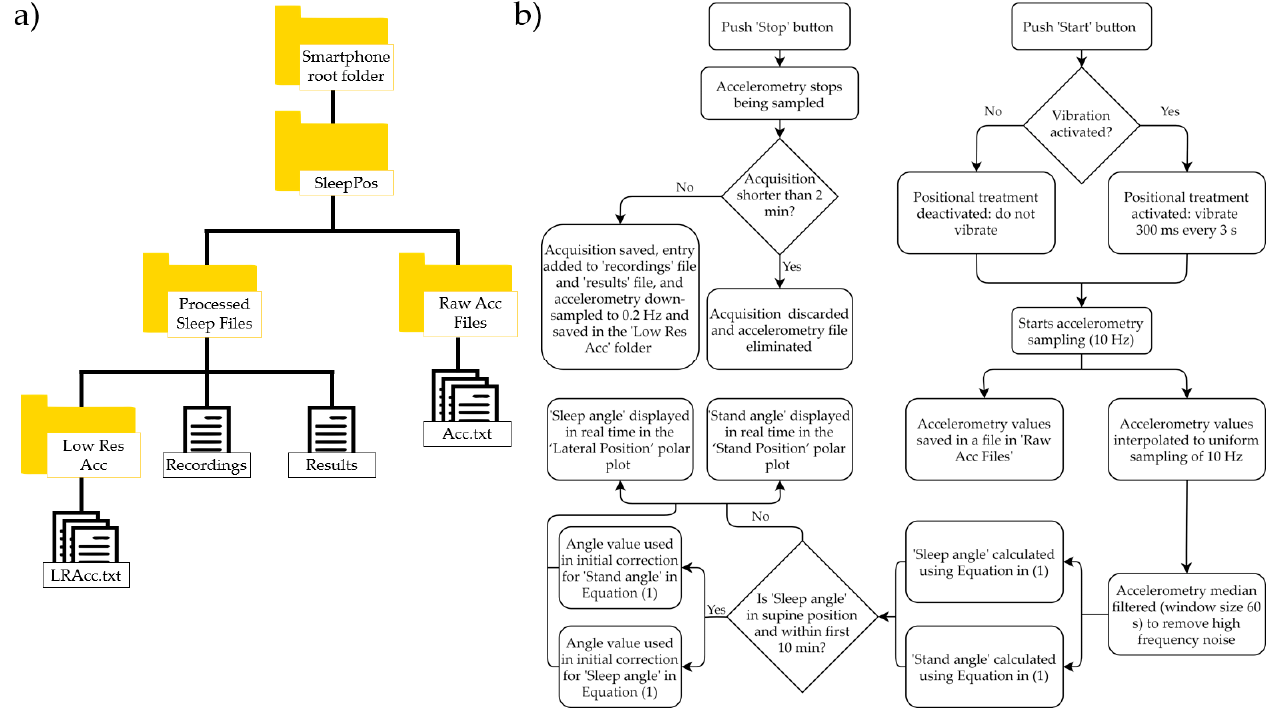
Figure 2. Folder structure of the app ( a ) used to store the raw and processed information from the accelerometry sensor of the smartphone. Raw accelerometry is saved within the ‘Raw Acc Files’ folder. The ‘Recordings’ file contains the register of the multiple recordings performed. The ‘Results’ file contains the register with the summarized processed information from the accelerometry, and the ‘Low Res Acc’ folder contains the low sampling frequency accelerometry used for data visualization. The diagram in ( b ) shows the logic applied in the app to acquire and process the accelerometry data.